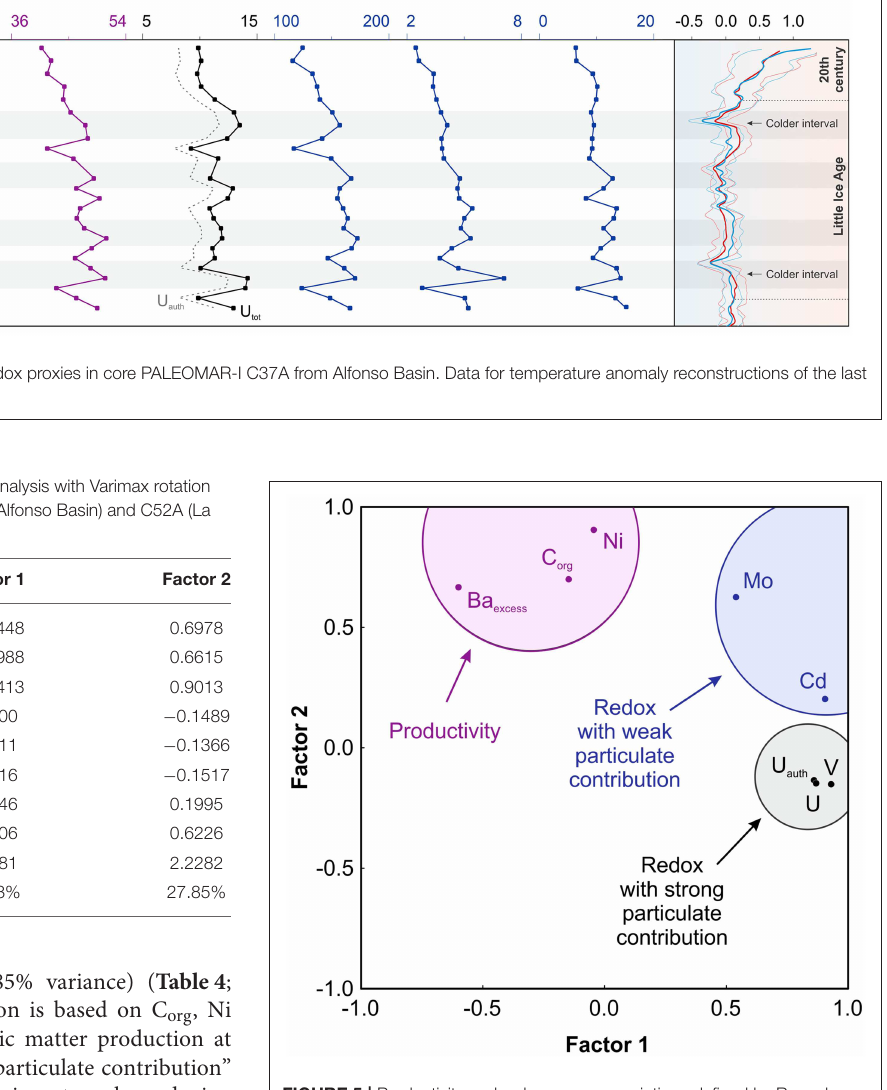
FIGURE 5 | Productivity and redox proxy associations defined by R-mode factor analysis of a combined geochemical dataset from Alfonso Basin (core C37A) and La Paz Basin